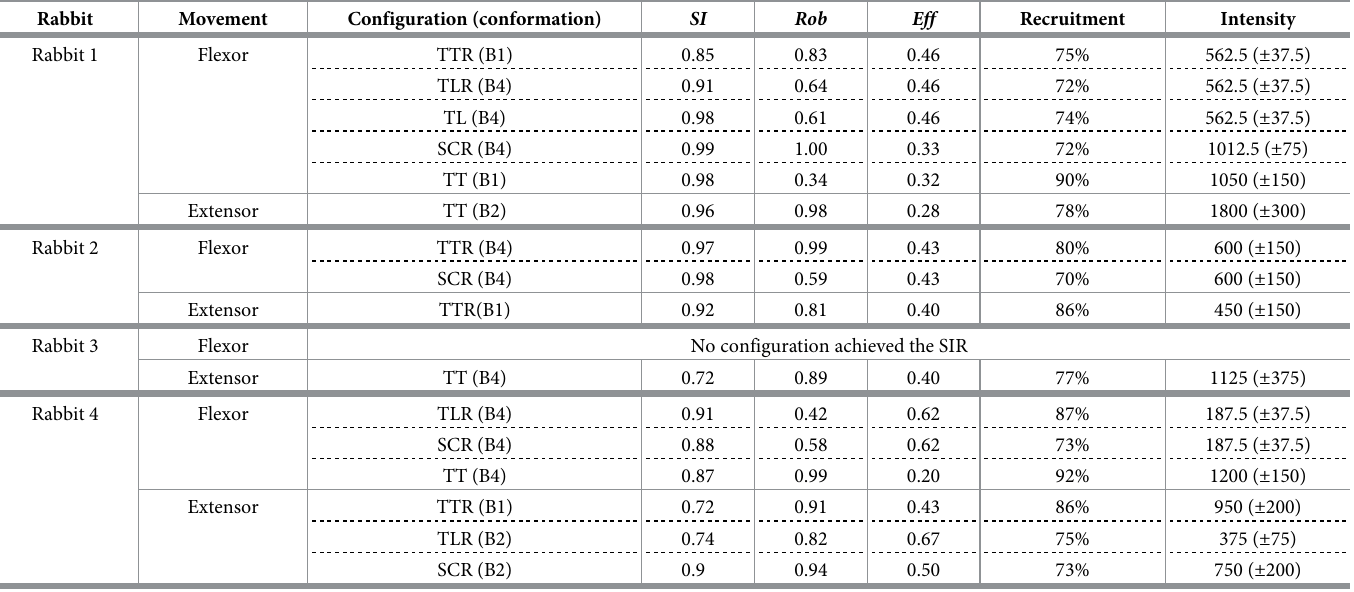
Table 6. Configurations that reach the SIR criteria for the antagonist and agonist groups. Rabbit